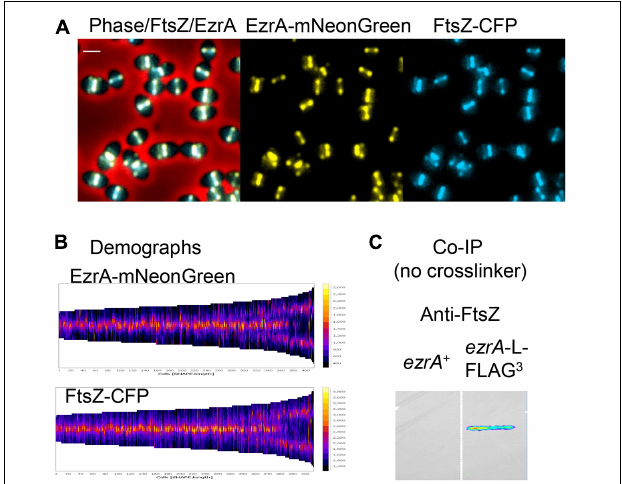
FIGURE 1 | Highly correlated localization patterns of FtsZ and EzrA during the Spn cell cycle. Cells from at least two independent biological replicates were collected at OD 620 ≈ 0.1–0.2 and prepared for microscopy or co-IP as described in section “Materials and Methods.” (A) Representative field of live cells expressing EzrA-mNeonGreen and FtsZ-CFP (IU14153). Scale bar is 1.0 µ m. (B) Demographs showing FtsZ and EzrA localization from shorter pre-divisional cells (left side) to longer post-divisional cells (right side). (C) Membrane probed with anti-FtsZ showing EzrA-FLAG 3 (IU5456) can co-IP FtsZ from non-crosslinked Spn cells relative to untagged EzrA + (IU10447).